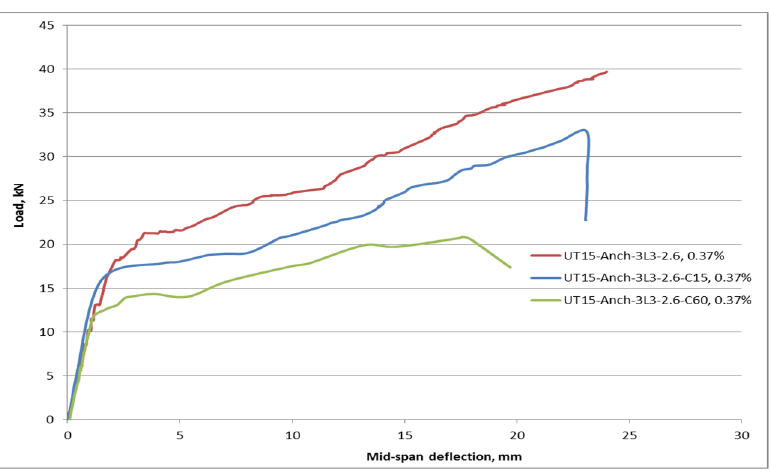
Figure 21. Effects of cover thickness on the mid-span load-deflection of TRC beams.